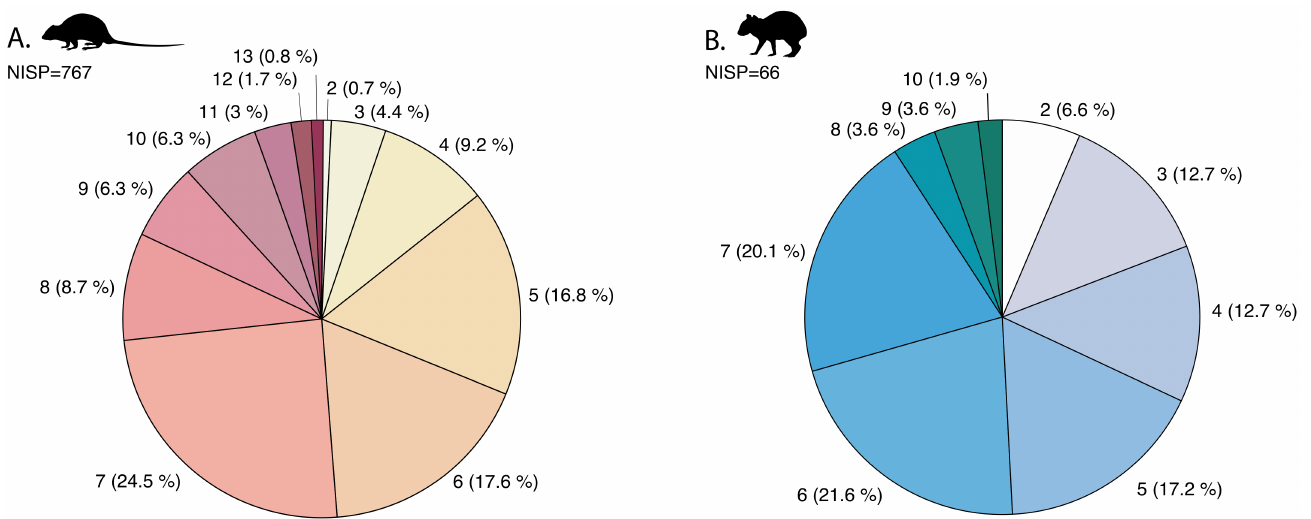
Figure 1. Pie chart representing the preservation for Oryzomyini ( A ) and Dasyprocta ( B ) mandibles according to the number of available landmarks (from 2 to 13). See Table S2 for the number of Oryzomyini and Dasyprocta specimens (NISP) for each digitalized